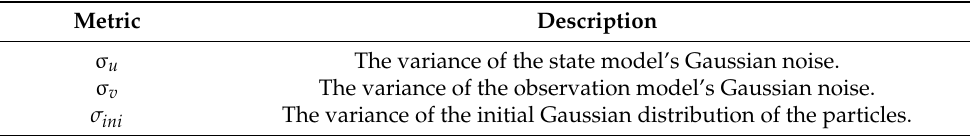
Table 8. Hyper-parameters.